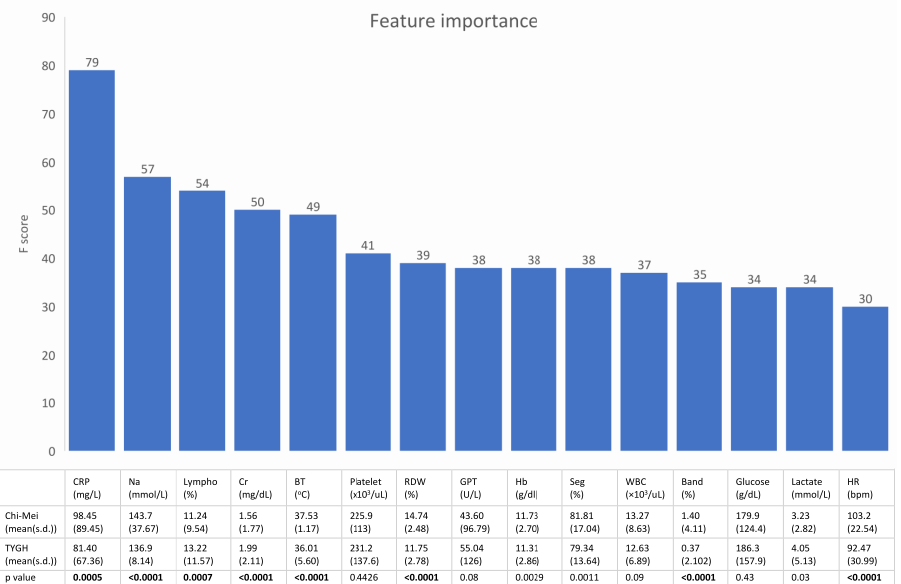
Figure 3. The upper bar plot shows the 15 top ranking features of the machine learning model. The lower table is the statistical analysis of these features between septic patients in the development dataset and septic patients in the external validation dataset. Most of the important predictors had a heterogeneous distribution between the two datasets. (Lympho = percentage of lymphocytes in the differential of the complete blood count).